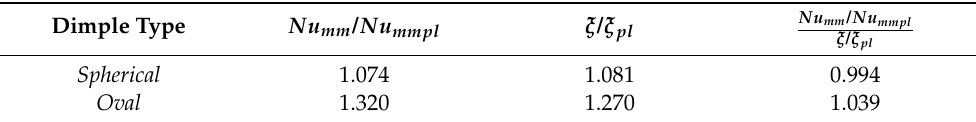
Figure 4. Averaged relative heat transfer in longitudinal ( a ) and transverse ( b ) directions for spheri- cal (1) and oval (2) dimples. Table 1. Comparison of the relative total heat transfer, hydraulic losses, and thermal-hydraulic efficiency (THE) of 15-dimple